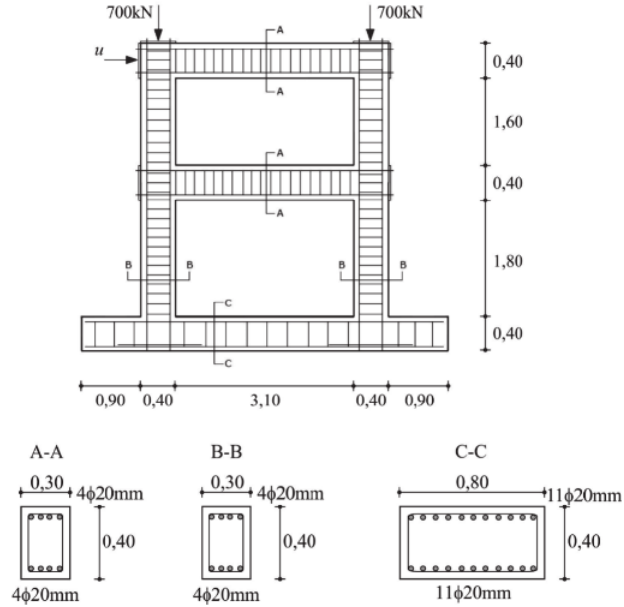
Figure 9 2D RC frame. Reinforcements’ scheme. Vecchio and Collins [27]. Dimensions in metre